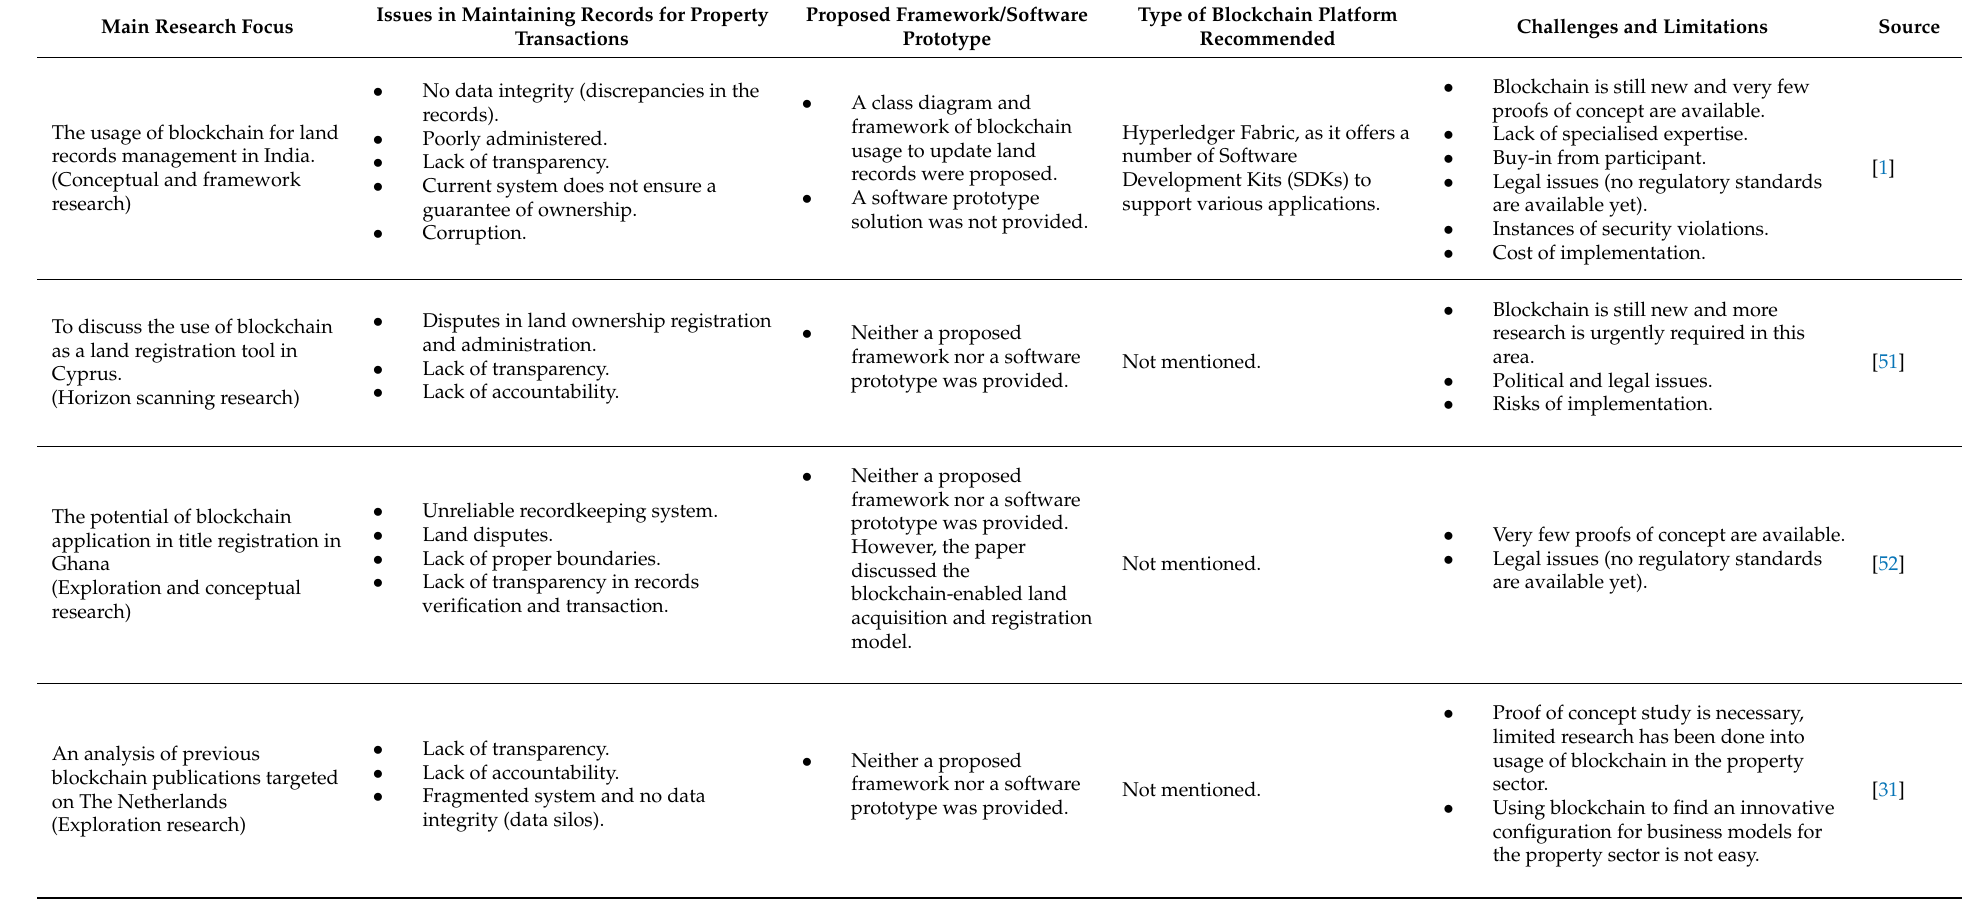
Table 1. A critical review of previous studies on application of blockchain technology for land registration and property